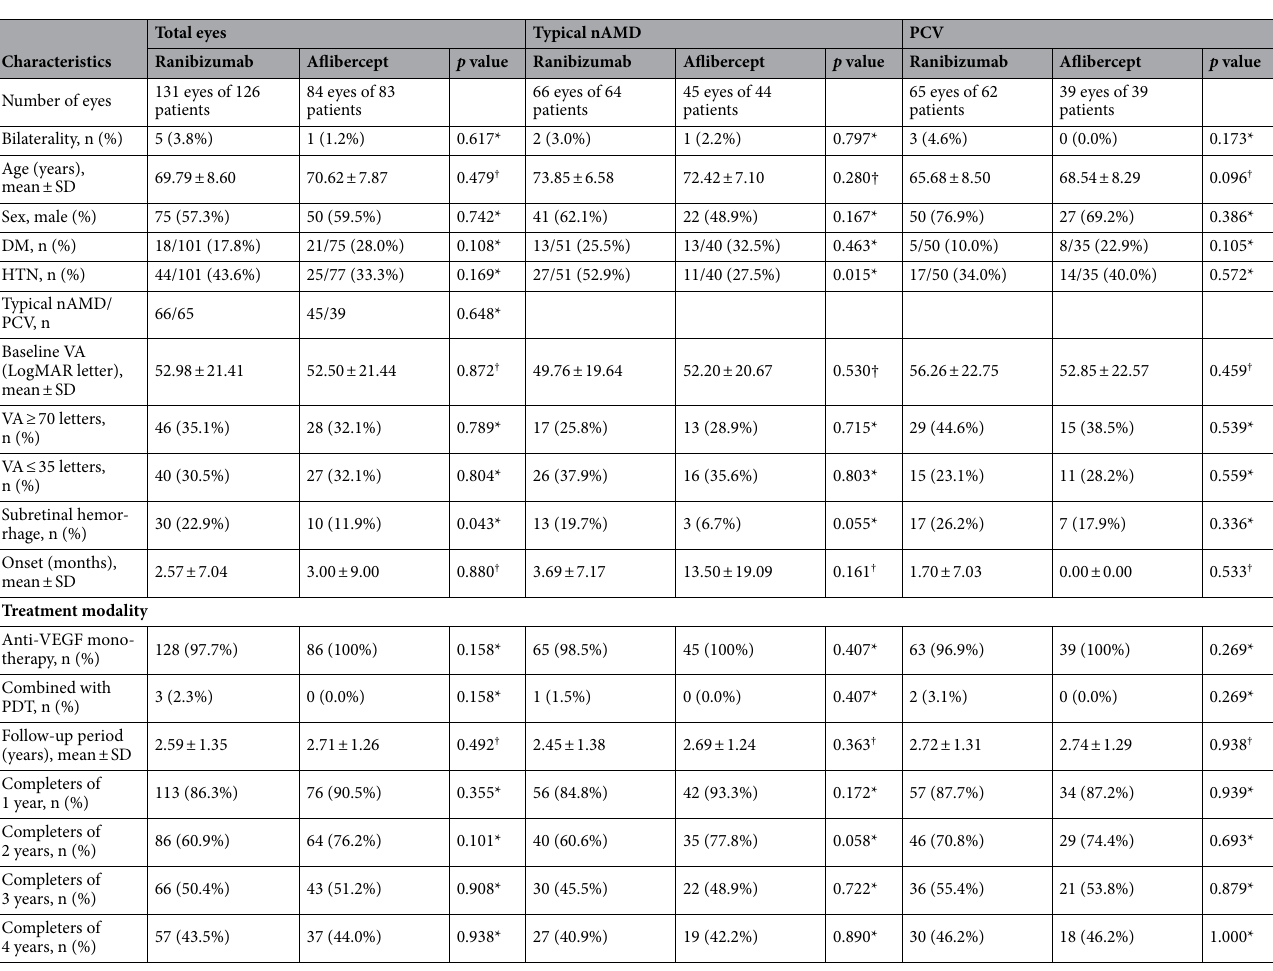
Table 1. Demographic and clinical characteristics of eyes treated with ranibizumab and aflibercept. DM diabetes mellitus, HTN hypertension, nAMD neovascular age-related macular degeneration, PCV polypoidal choroidal vasculopathy, VA visual acuity, LogMAR Log minimum angle of resolution, SRH subretinal hemorrhage, Anti-VEGF anti-vascular endothelial growth factor, PDT photodynamic therapy. *Pearson chi- square test. † Independent